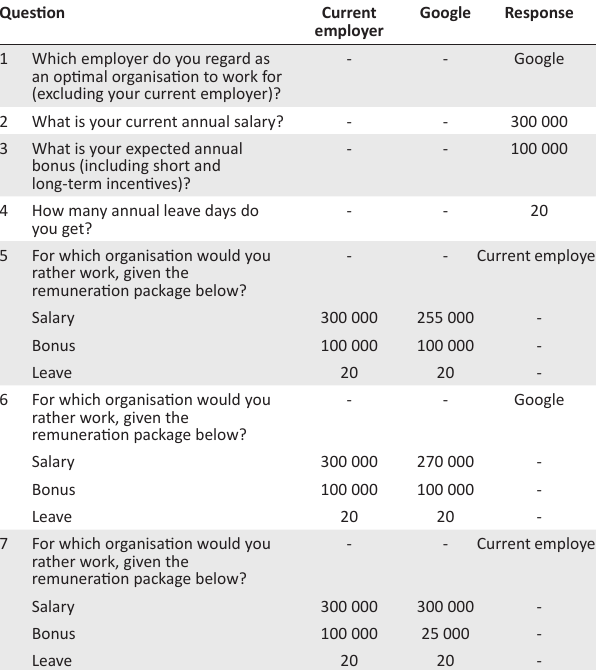
TABLE 2: Example of compensation-preference